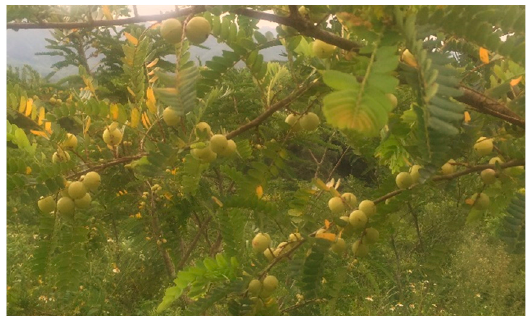
Figure 1. Phyllanthus emblica